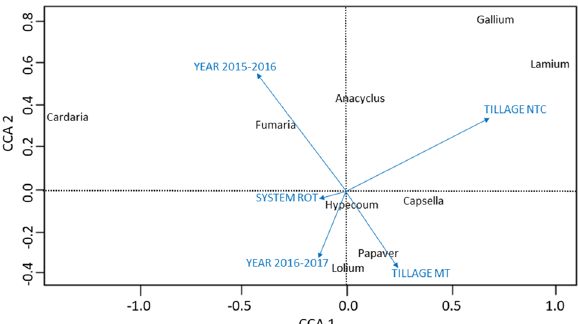
Figure 1. Ordination diagram of the reduce CCA model. In black = Weed species (only genus designation); in blue = the 5 significant explanatory variables. Only the species with the highest fit on the first two CCA axes are presented.